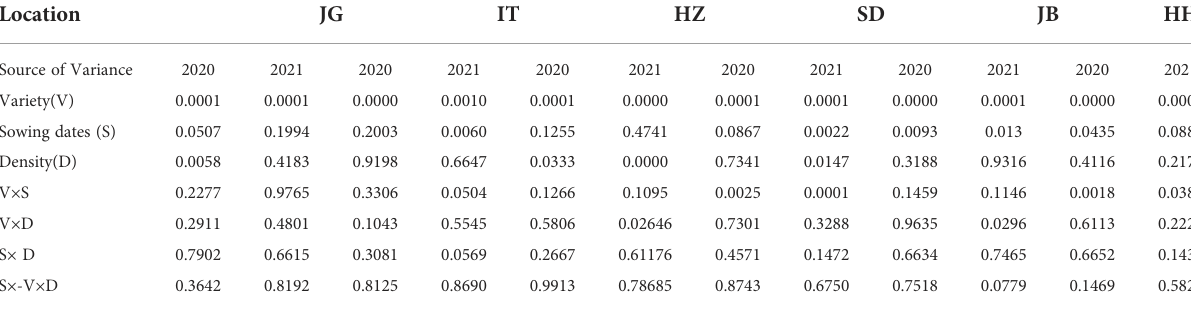
TABLE 2 Signi fi cant P value of ANOVA in different locations and years.